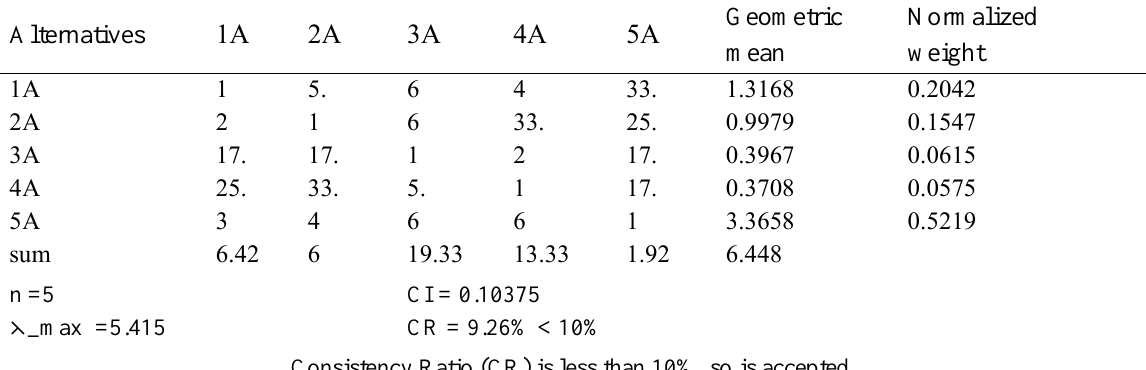
Table 12. Comparison Matrix of Alternatives with respect to C8.